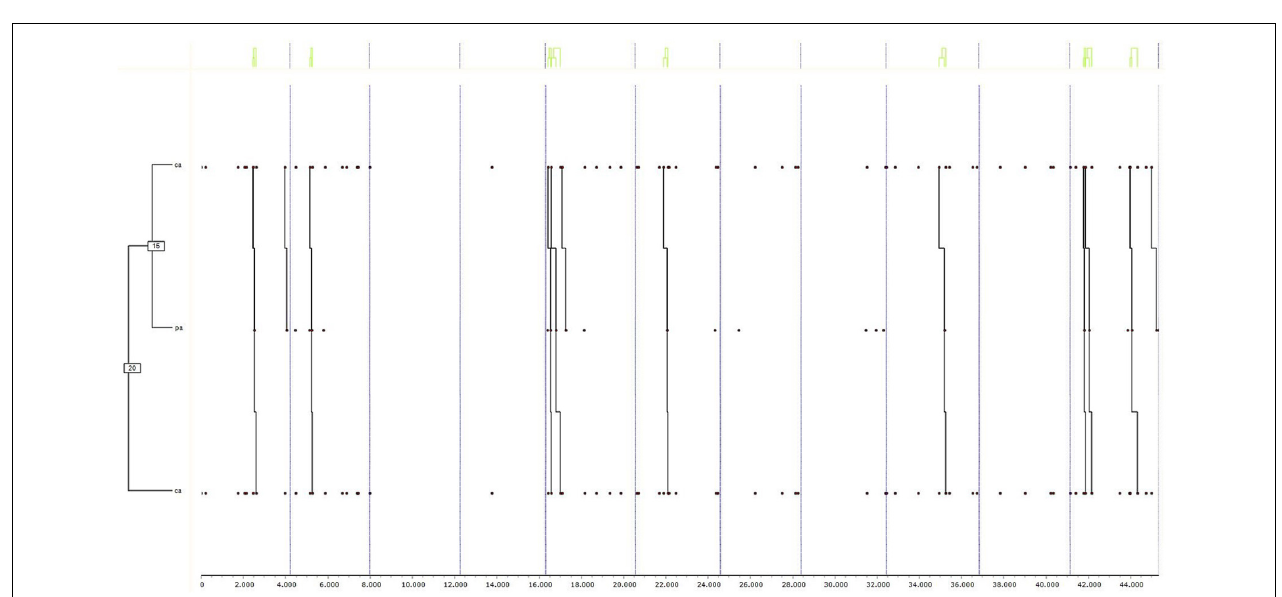
FIGURE 2 | Dendogram obtained from THEME belonging to group “1” exclusively in girls. The decisional categories of the mixed registration system ( Table 1 ) were used for searching for T-patterns.